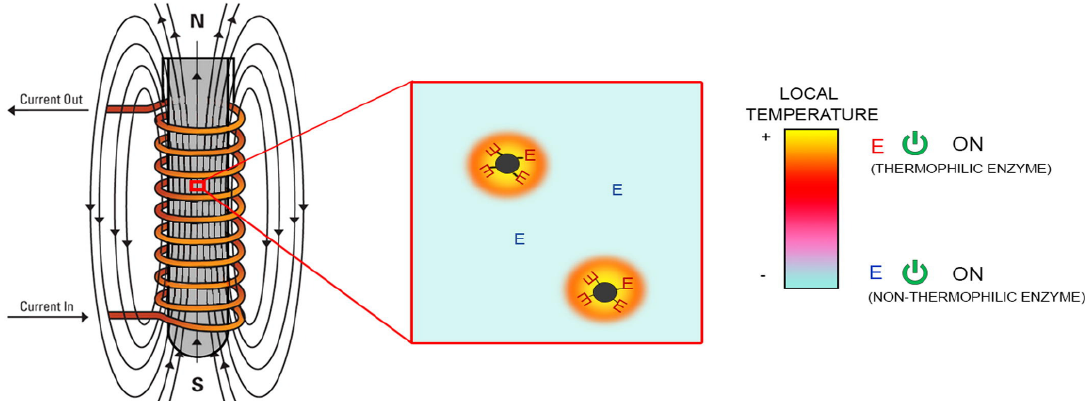
Figure 9. The procedure of thermophilic enzymes-Fe 3 O 4 nanocomposites activated by local magne- tothermal effect upon AMF due to the molecular vibration of MNPs. The non-thermophlic enzyme without immobilized on Fe 3 O 4 nanoparticles can work together with the thermophilic enzymes- Fe 3 O 4 nanocomposites in the same reaction due to the local magnetothermal effect. Adapted with permission from Armenia et al., Elsevier [135].